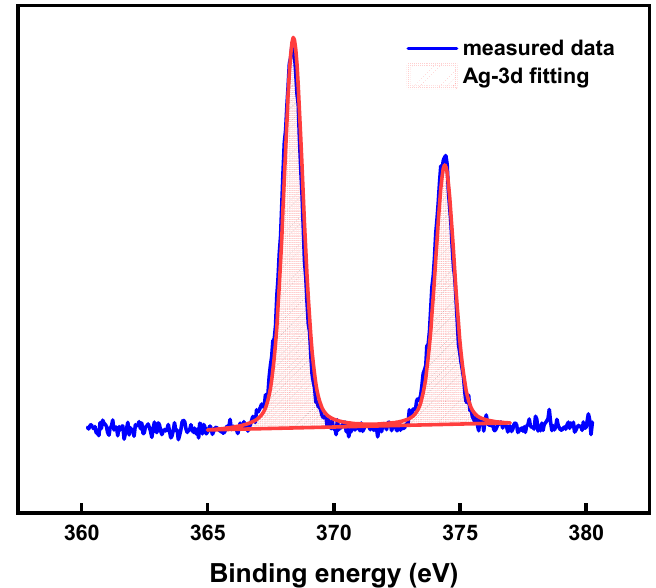
Figure 5. Ag-3d X-ray photoelectron spectroscopy (XPS) scanning atlas and fit analysis of the XPS spectra under 200 °C annealing.